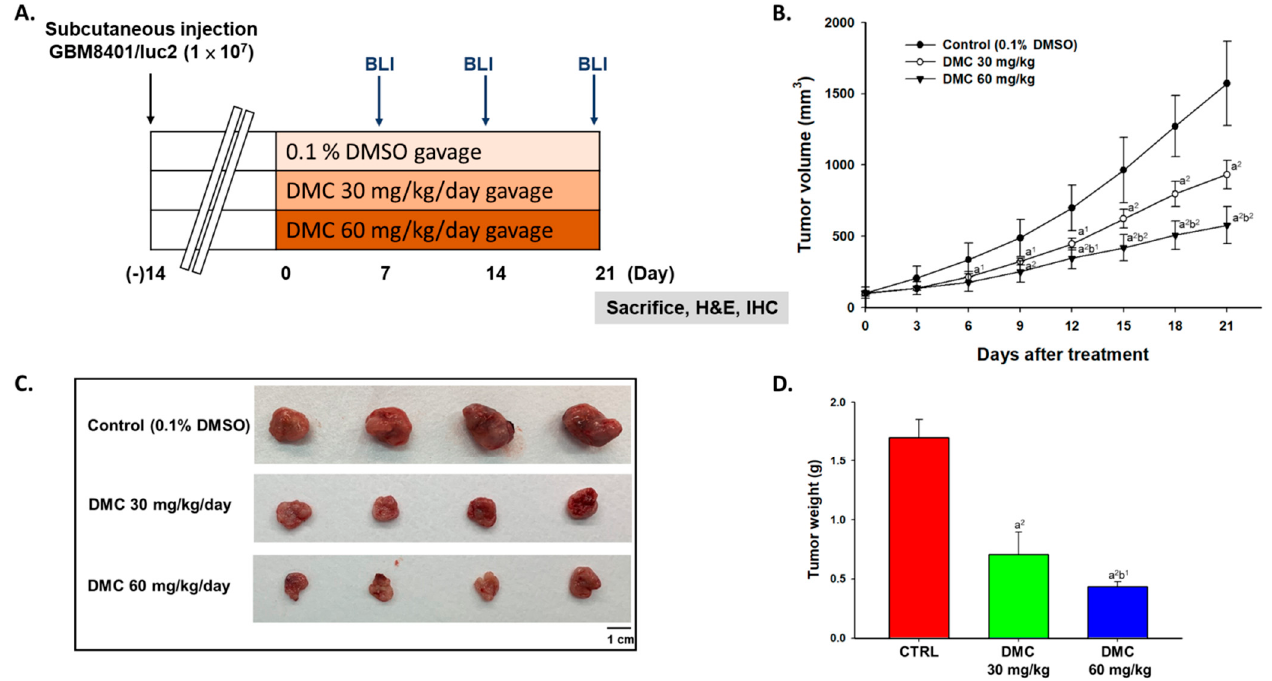
Figure 1. Tumor growth was inhibited by DMC treatment. ( A ) An animal experiment flow chart was displayed. ( B ) Tumor volume was measured by caliper every three days and quantified. ( C ) Tumors were isolated and photographed from each group of mice on day 21. ( D ) Tumor weight was also measured and quantified. (a 1 p < 0.05 and a 2 p < 0.01 vs. control; b 1 p < 0.05 and b 2 p < 0.01 vs. DMC 30 mg/kg).